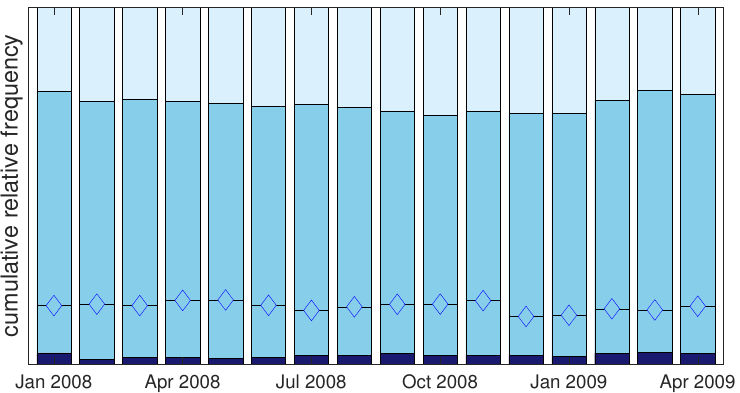
Figure 2. Proportion of LGD observations for each month at 1 (dark blue bar), 0 (light blue bar), and on the intervals ( 0,0.01 ) and [ 0.01,1 ) (medium blue bar with diamonds at